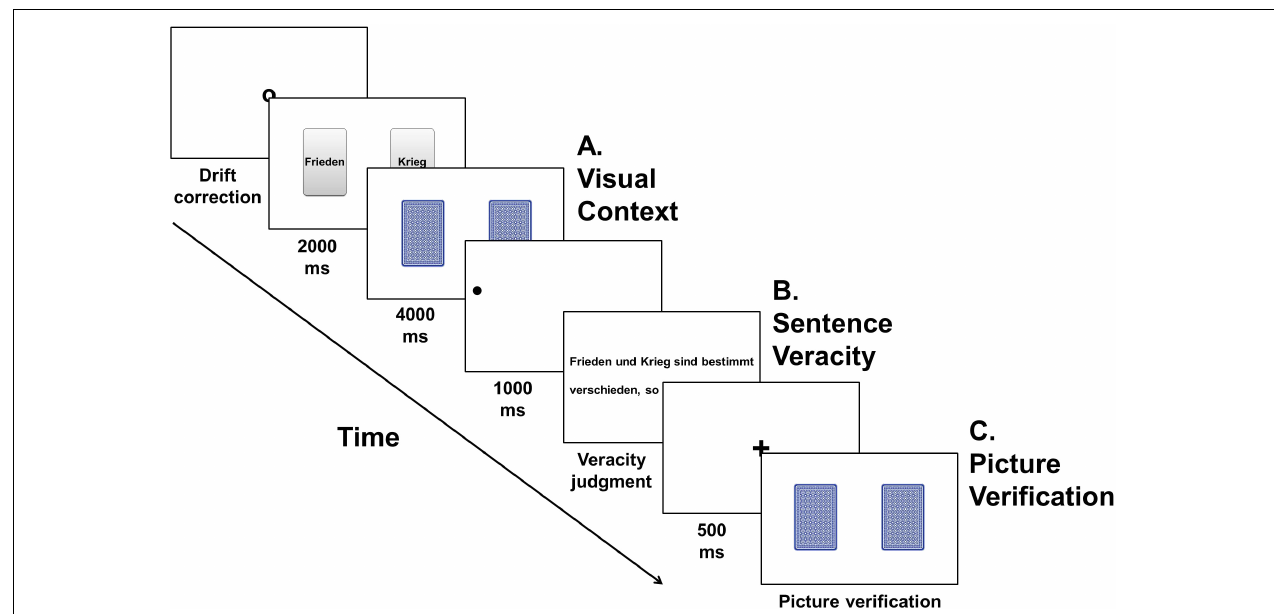
FIGURE 1 | Schematic representation of an experimental trial for Experiment 1.